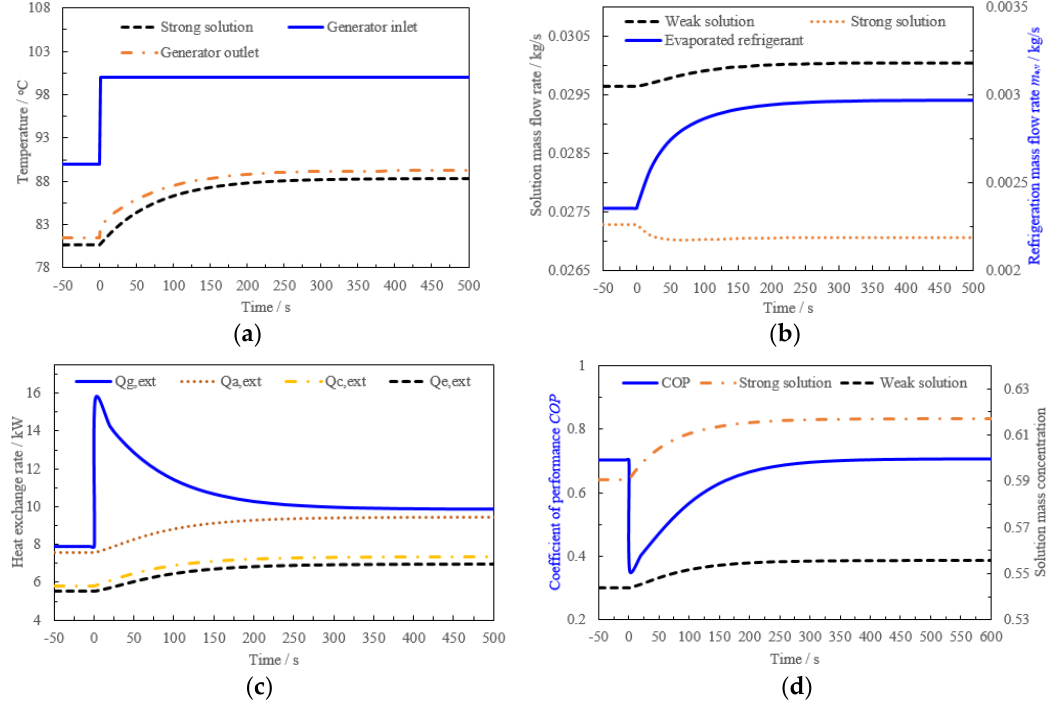
Figure 5. Dynamic response to 10 °C step change of T gin ( T cin = 32 °C, T ein = 12 °C); ( a ) The temperatures